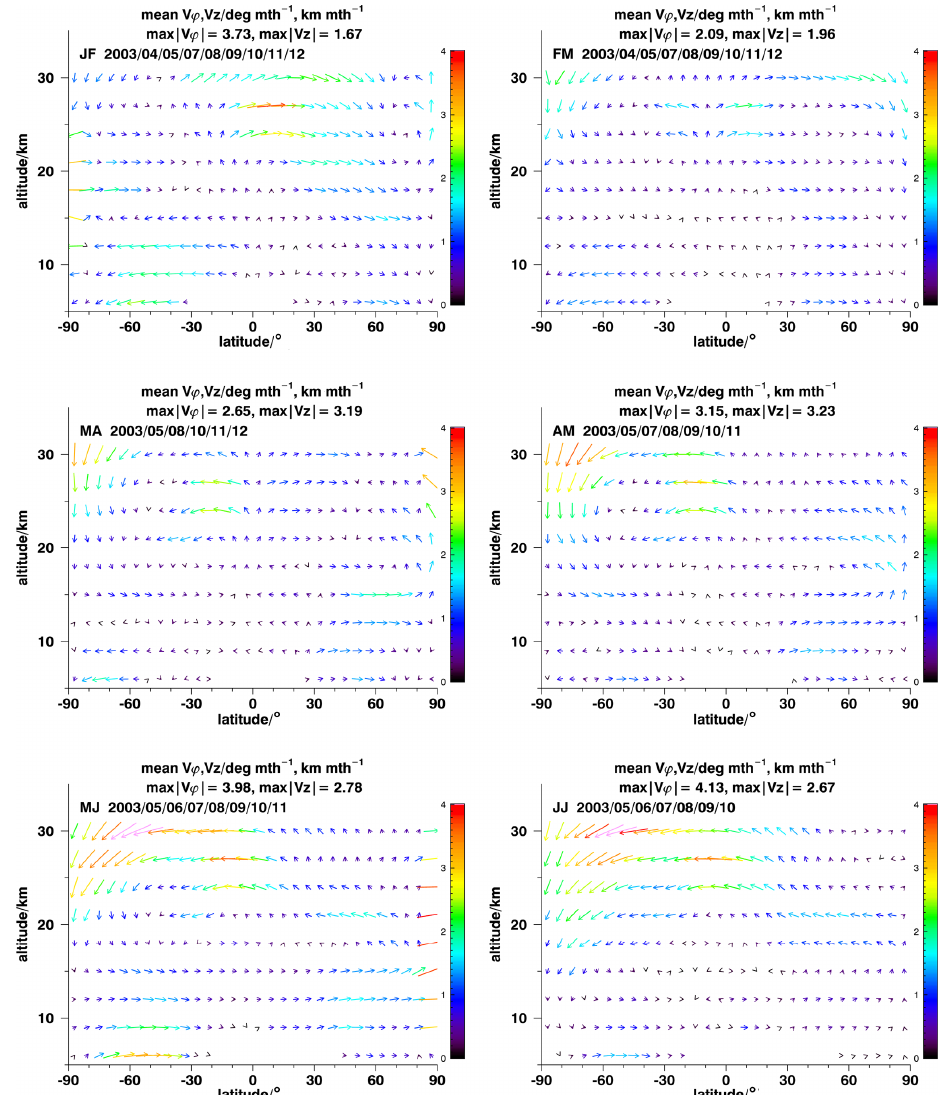
Figure 3. Same as Fig. 1 but for altitudes of up to 30km